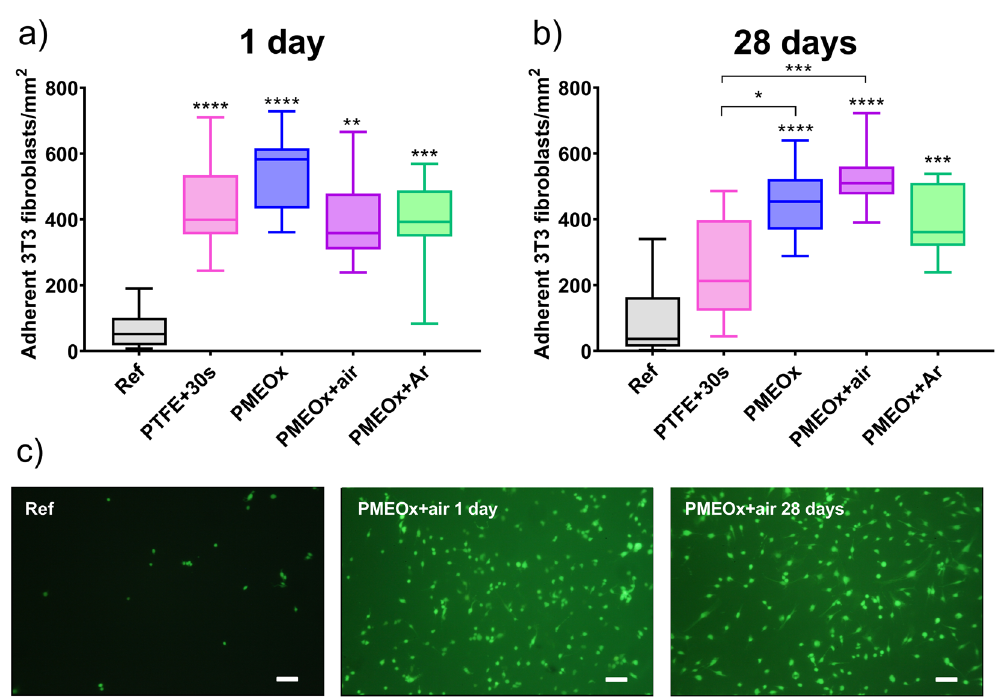
Figure 8. Study of the adhesion of 3T3 fibroblasts on PTFE and on POx surfaces after 24 h incubation. ( a ) Density of adherent cells on selected samples ( Ref - raw PTFE, PTFE + 30 s - PTFE after 30 s of air plasma treatment, PMEOx – without plasma post-treatment , PMEOx + air – plasma post-treatment in air , PMEOx + Ar – plasma post-treatment in argon) 1 day after preparation. The box represents the median values and interquartile ranges of the number of adherent cells per mm 2 , the whiskers represent minimal and maximal values. ** p < 0.01, *** p < 0.001, **** p < 0.0001, compared to ref ( b ) Density of adherent cells on selected samples after 30 days of aging. * p < 0.05, *** p < 0.001, **** p < 0.0001, compared to ref or PTFE + 30 s , ( c ) Representative fluorescent images of adherent cells stained by green FDA. Scale bar = 50 μ